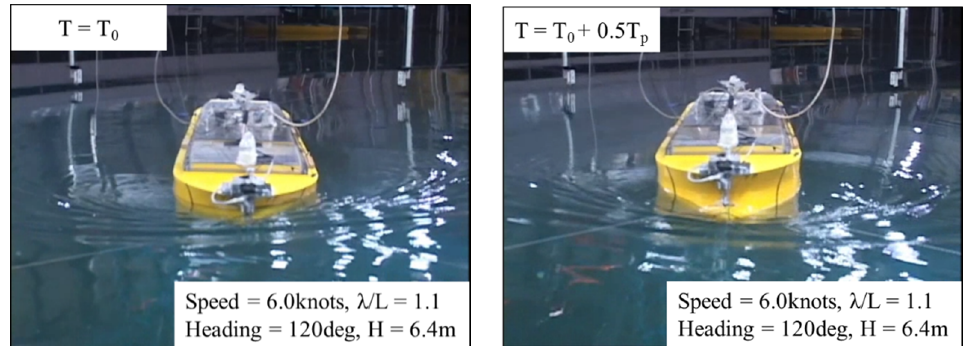
Figure 4. Snapshots of experiment: Speed = 6.0 knots, λ /L = 1.1, heading = 120 deg, H = 6.4 m.